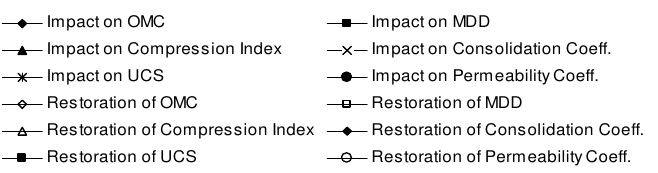
Figure 3 . Contaminnat Impact and Restoration of